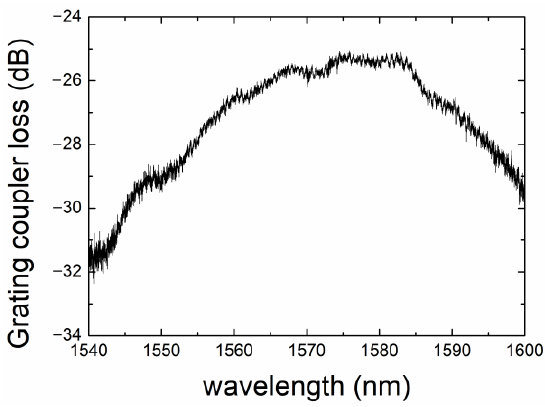
Figure 10. Measured optical loss induced by the input and output grating